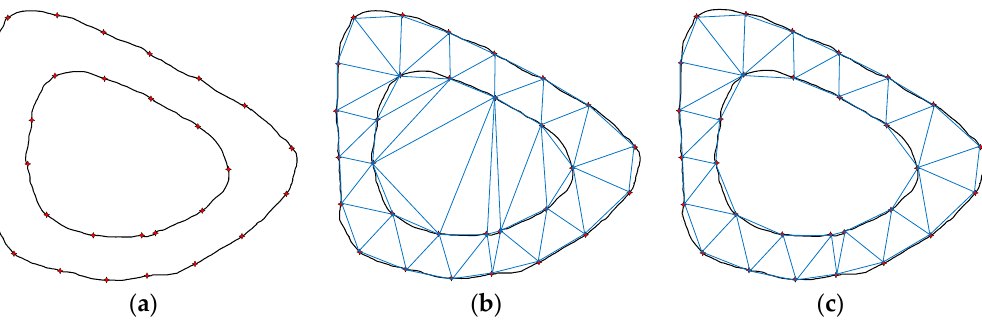
Figure 8. Example of Lawson algorithm: ( a ) original image; ( b ) error graph; ( c ) correct figure.